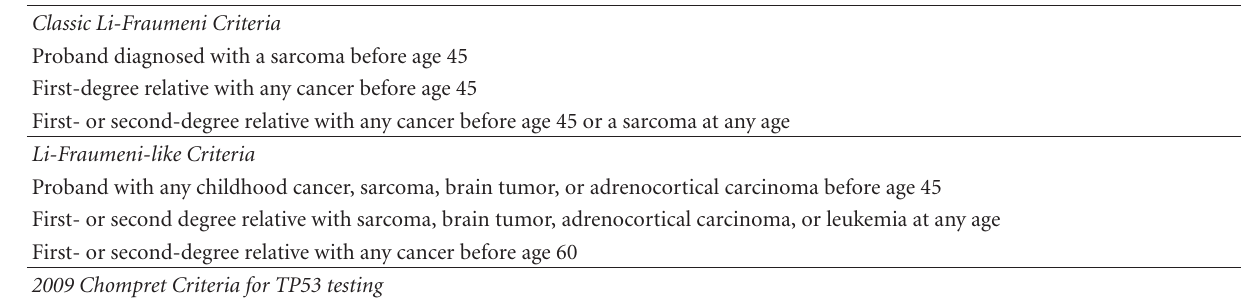
Table 2: Li-Fraumeni diagnosis and screening